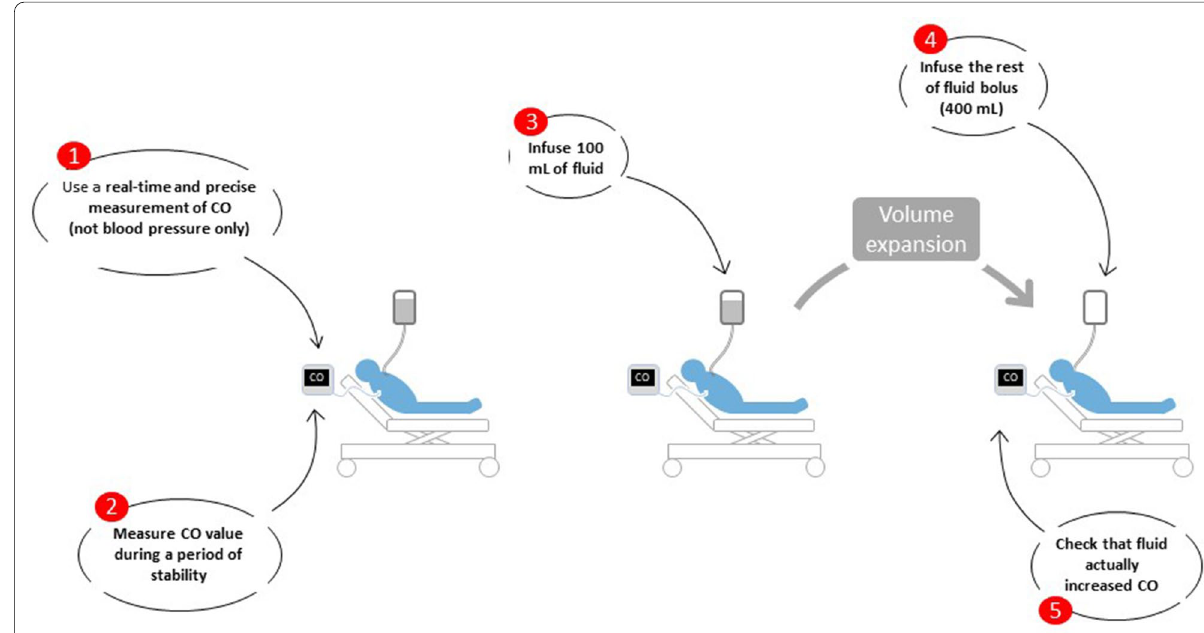
Fig. 3 Practical rules for performing a mini‑fluid challenge. CO cardiac